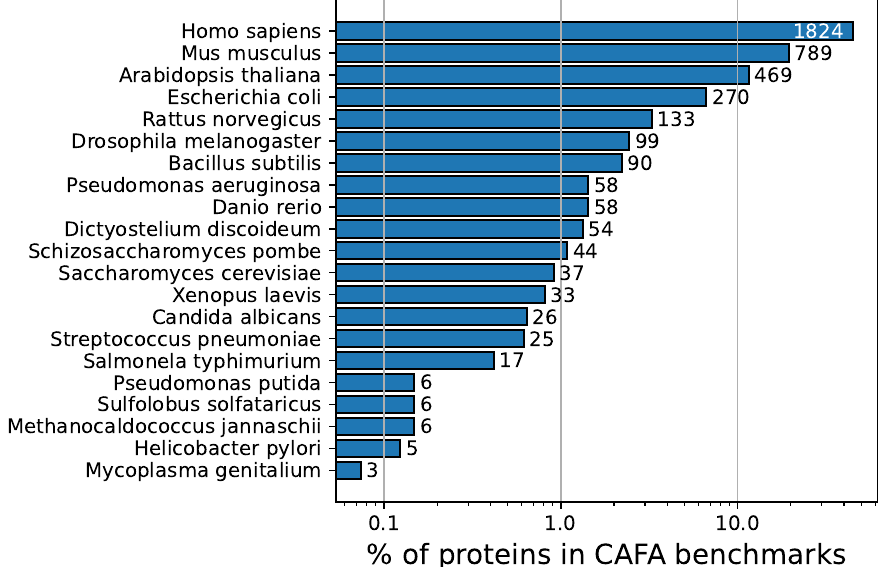
Figure 3. Percentage of proteins used in the three CAFA benchmarks [10–12] ( x -axis, in log scale) per species. The absolute number of proteins per species is also given next to the bars. Only newly-annotated proteins are included, i.e., proteins that had no GO annotations before the benchmark (referred to as No-Knowledge benchmarks in CAFA). CAFA: Critical Assessment of Functional